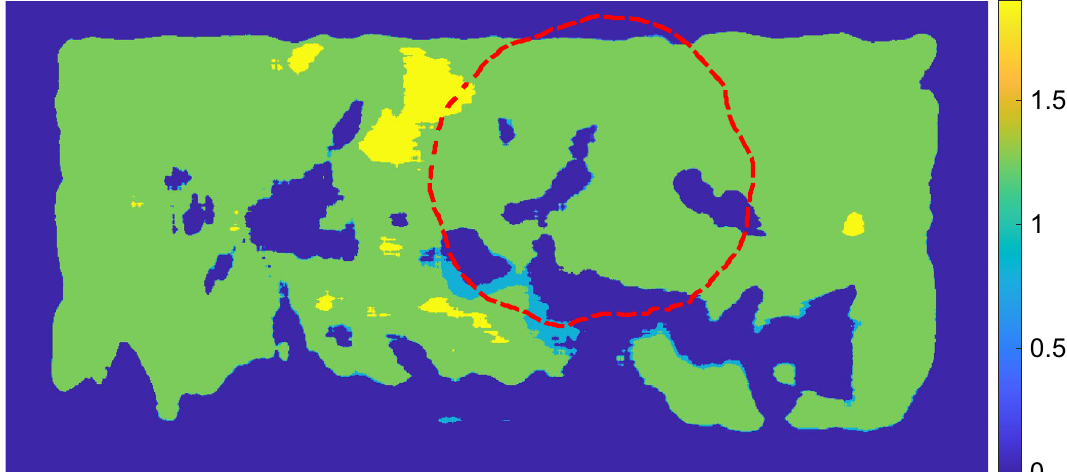
Figure 2. Example of chart based on the phase shift measure for the frequencies 0.02–0.08 Hz. Resection mask is shown with red dashed